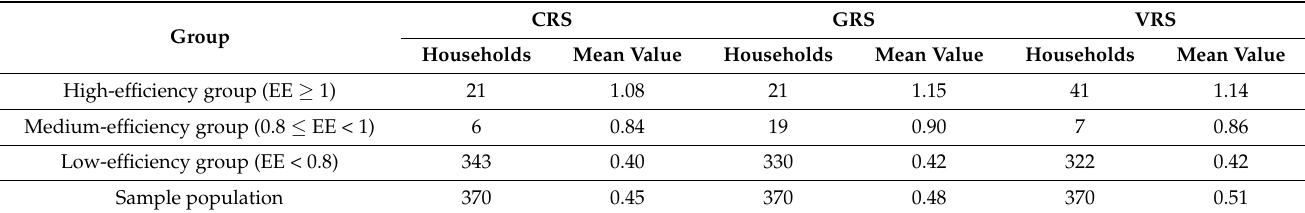
Table 6. Household eco-efficiency of rice production in the sampled